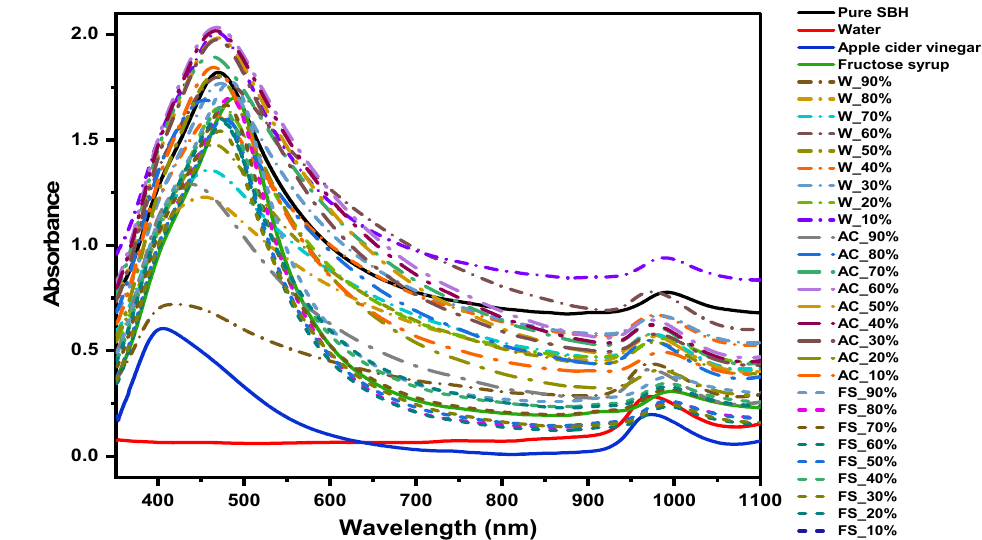
Figure 1. Spectra for pure SBH, adulterants, and adulterated SBH samples ( n =